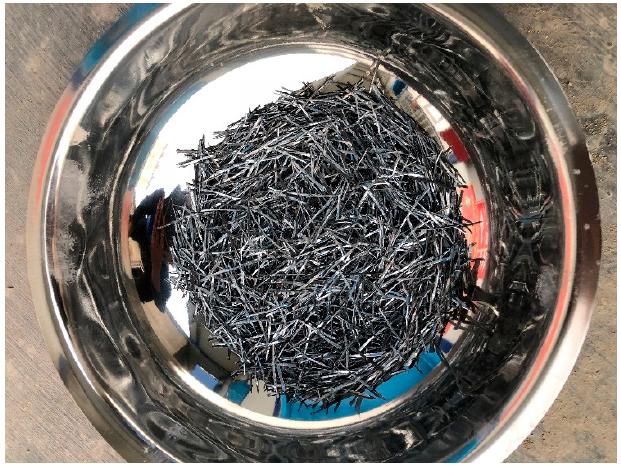
Figure 1. Photograph of wavy steel fibers.